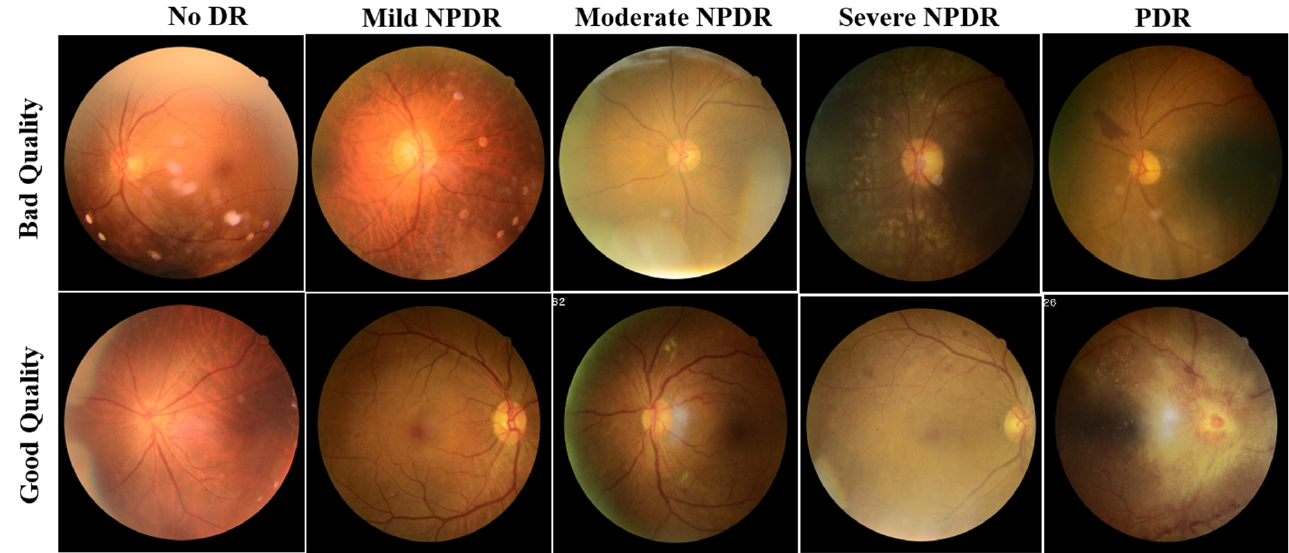
Figure 1. Sample fundus images of DeepDRiD dataset for good and bad quality, shown for all grades of DR. DR: diabetic retinopathy, NPDR: non-proliferative diabetic retinopathy, PDR: proliferative diabetic